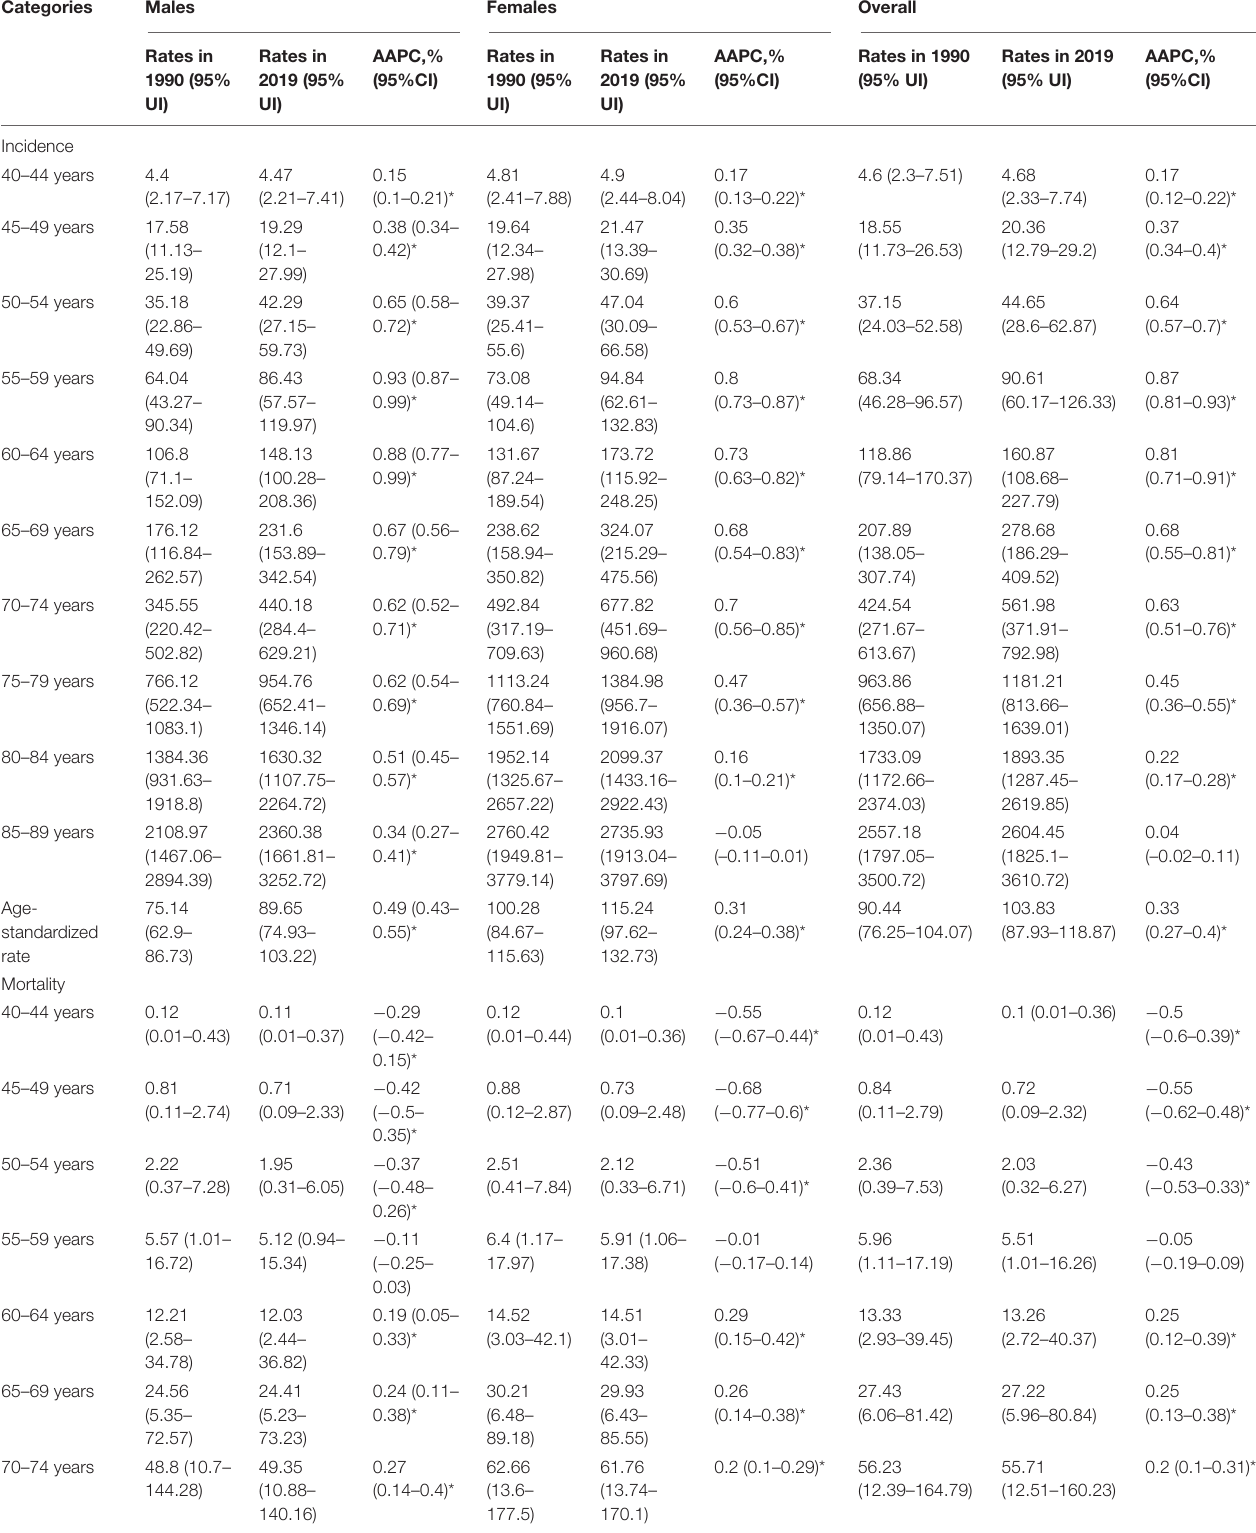
TABLE 1 | Sex- and age-specific rates of Alzheimer’s disease and other forms of dementia in China in 1990 and in 2019 and their average annual percentage changes (AAPC) from 1990 to 2019.